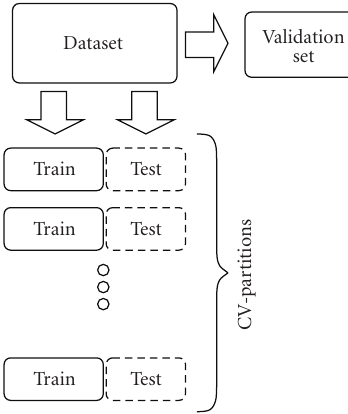
Figure 2: For every partition of the cross-validation, the data is divided in a training and a test set. The performance of each ensemble model was assessed on validation set which was initially removed and never included in model